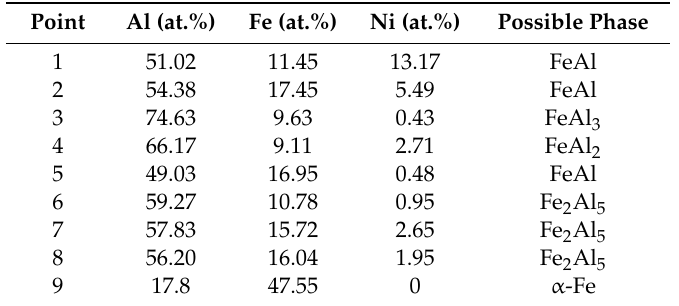
Table 1. EDS result of the marked points in the Fusion Zone (FZ) in the weld.